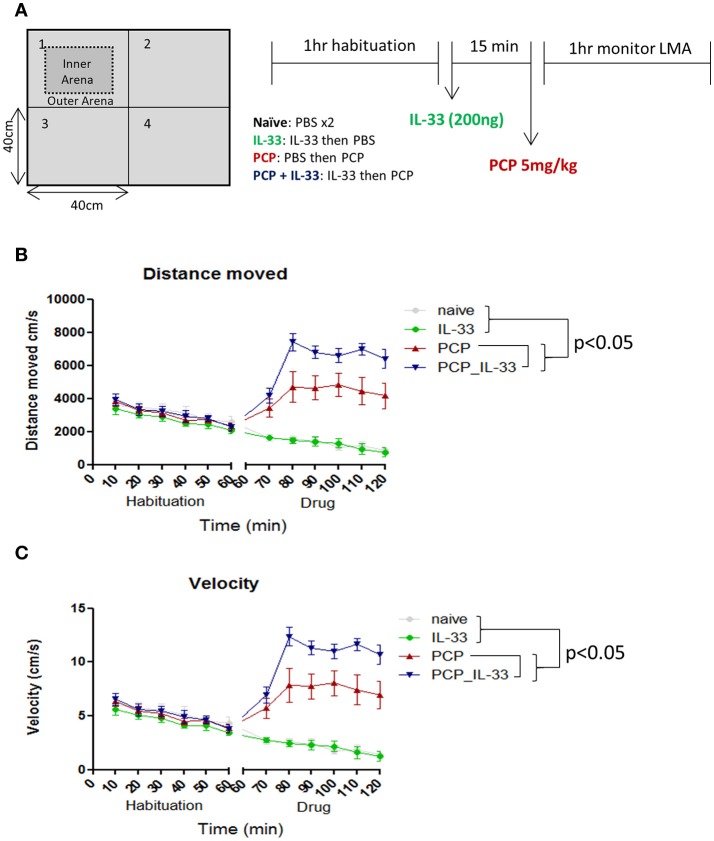
IL-33 enhances PCP-induced changes in locomotor activity. (A) C57BL/6 mice were first habituated inside a 40 × 40cm open field maze for 1 h before being taken out of the maze and injected intraperitoneally with vehicle control (PBS) or 200 ng IL-33. After 15 min mice received an i.p. injection of either PBS or PCP (5 mg/kg), and were then placed back into the same open field maze for 1 h. Their (B) distance moved and (C) velocity were tracked via overhead cameras and analyzed. Significant (p < 0.05) pairwise differences according to Tukey's post hoc test show PCP_IL-33 > PCP > naïve and IL-33 for both distance moved and velocity. LMA: locomotor activity.